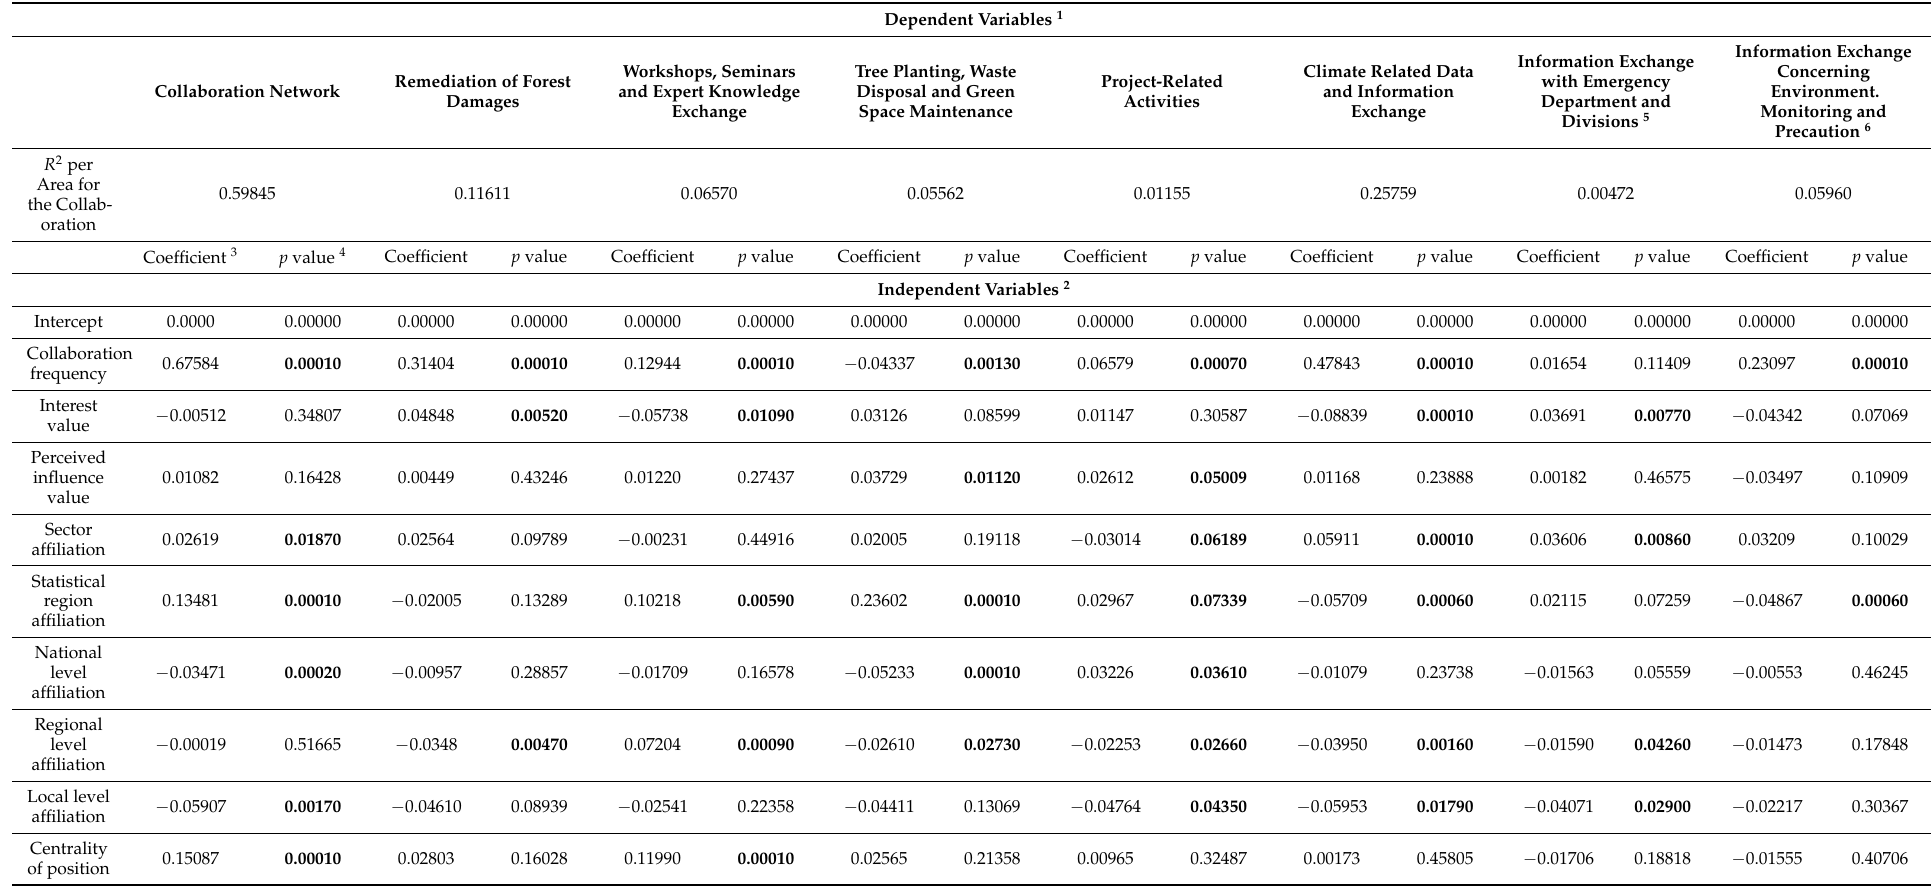
Table 6. Multiple regression quadratic assignment procedure (MRQAP) via double dekker semi-partialling per area for the collaboration and selected